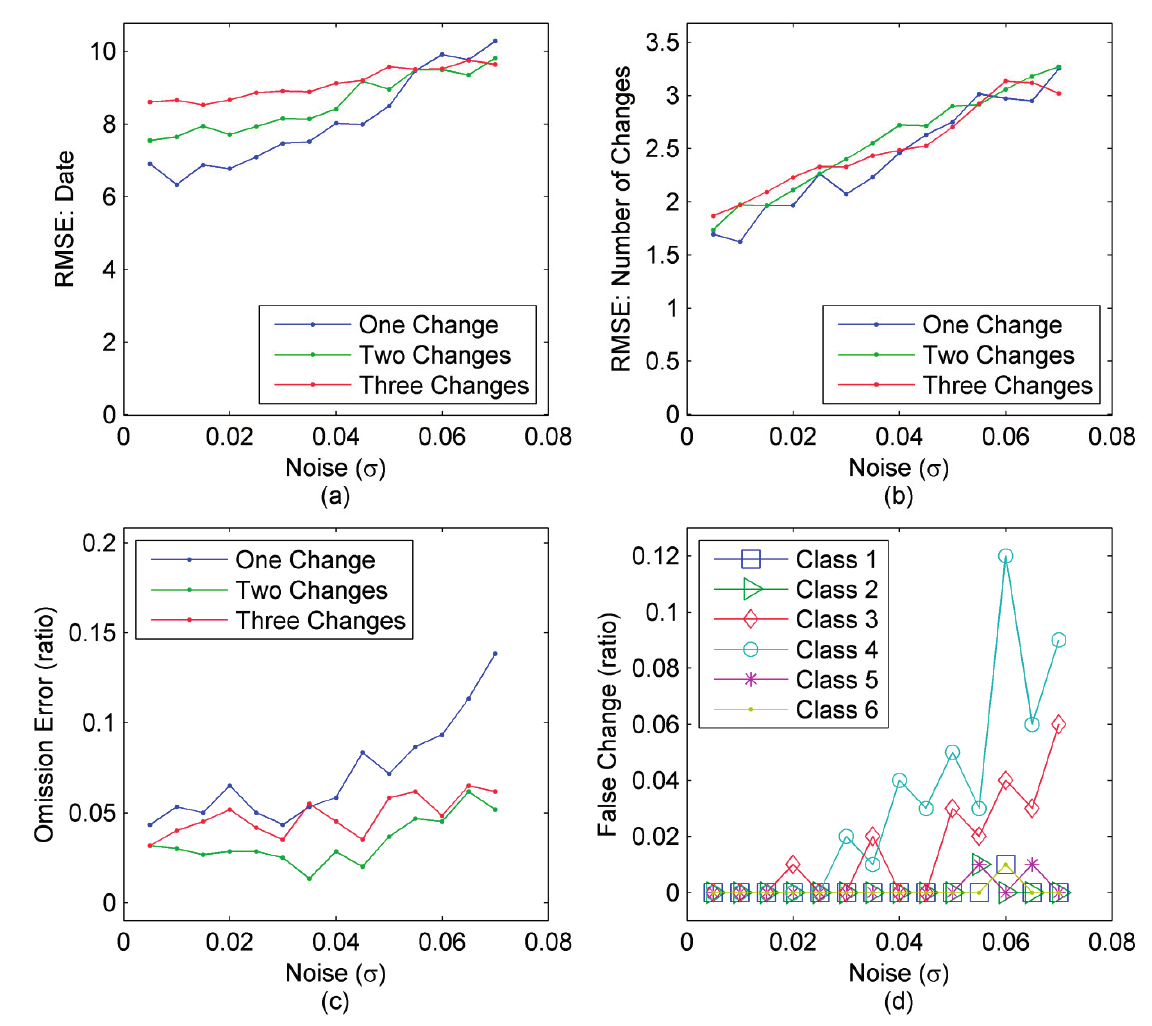
Figure 5. The influence of noise and change intensity on the RMSE of change time ( a ); RMSE of number of changes ( b ); and omission errors ( c ) of simulated time series, and the influence of noise on stable time series represented by the ratio of false change calculated for Classes 1–6 ( d ). In each plot, the X-axis represents the standard deviation ( σ ) of white noise added to the time